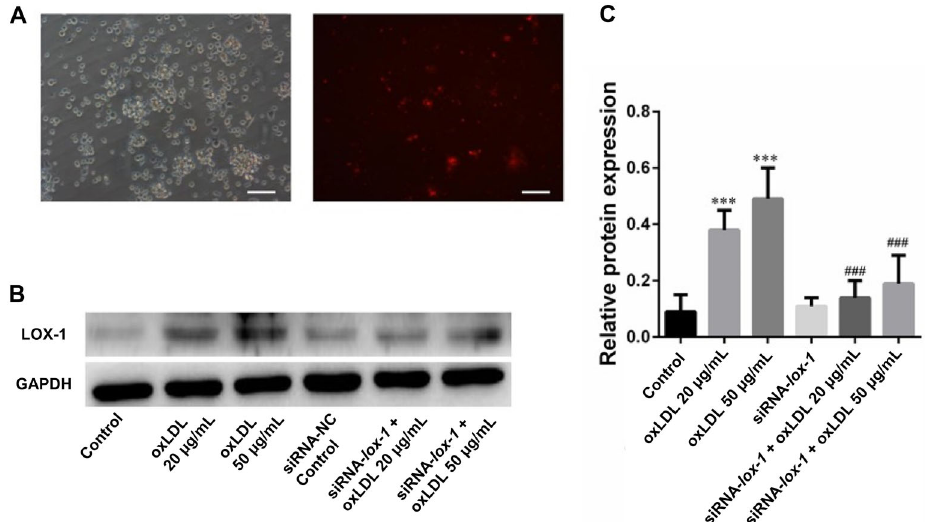
Figure 3. Dendritic cells (DCs) transfected with siRNA-LOX-1 and LOX-1 expression. A , The fl uorescence observation of DCs after transfection with siRNA-cy3. Scale bar=200 m m. B and C , Expression of LOX-1 in DCs after transfection with siRNA-LOX-1 and treatment by oxidized low-density lipoprotein (oxLDL). Data are reported as means ± SD (n=3). ***P o 0.01 vs control, ### P o 0.01 vs un-transfected groups (ANOVA).